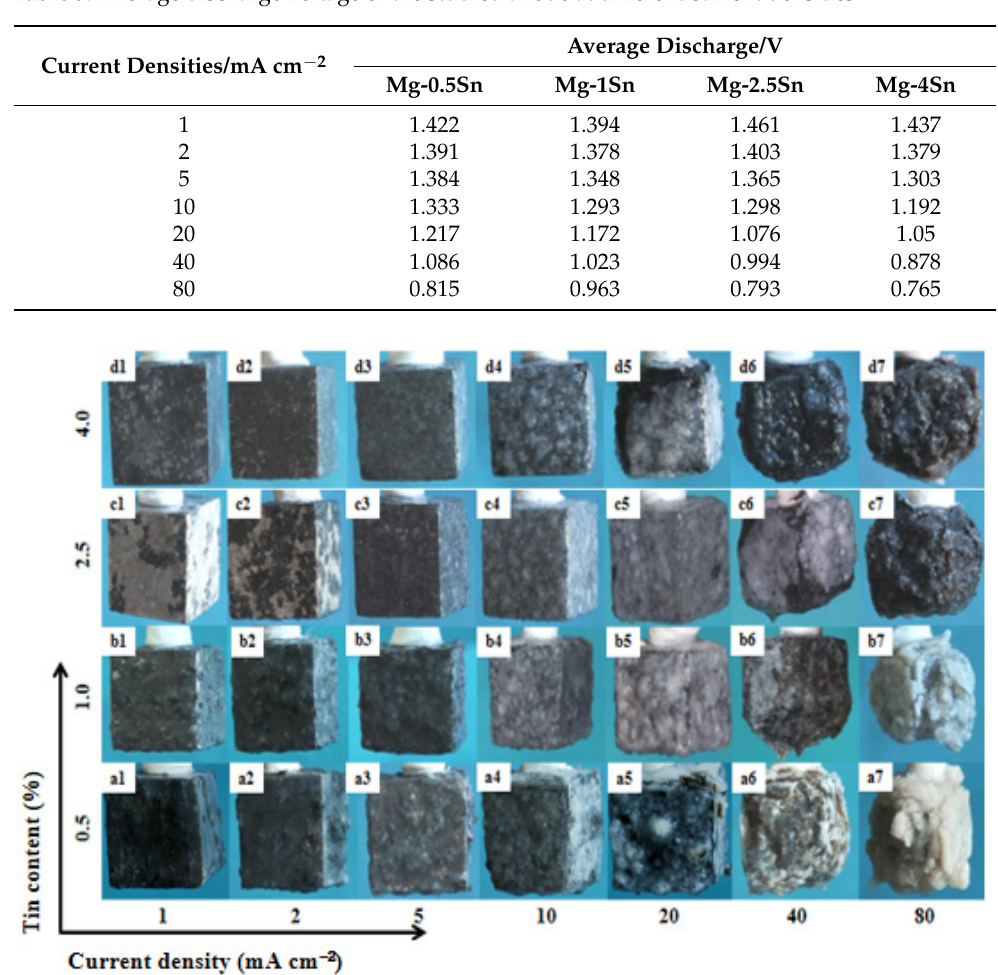
Figure 8. Macroscopic surfaces of the four studied anodes after 10 h of discharge at different current densities in 3.5 wt.% NaCl solution: ( a1 – 7 ) Mg-0.5Sn, ( b1 – 7 ) Mg-1Sn, ( c1 – 7 ) Mg-2.5Sn, and ( d1 – 7 ) densities in 3.5 wt.% NaCl solution: ( a1 – a7 ) Mg-0.5Sn, ( b1 – b7 ) Mg-1Sn, ( c1 – c7 ) Mg-2.5Sn, and Mg-4Sn. ( d1 – d7 )